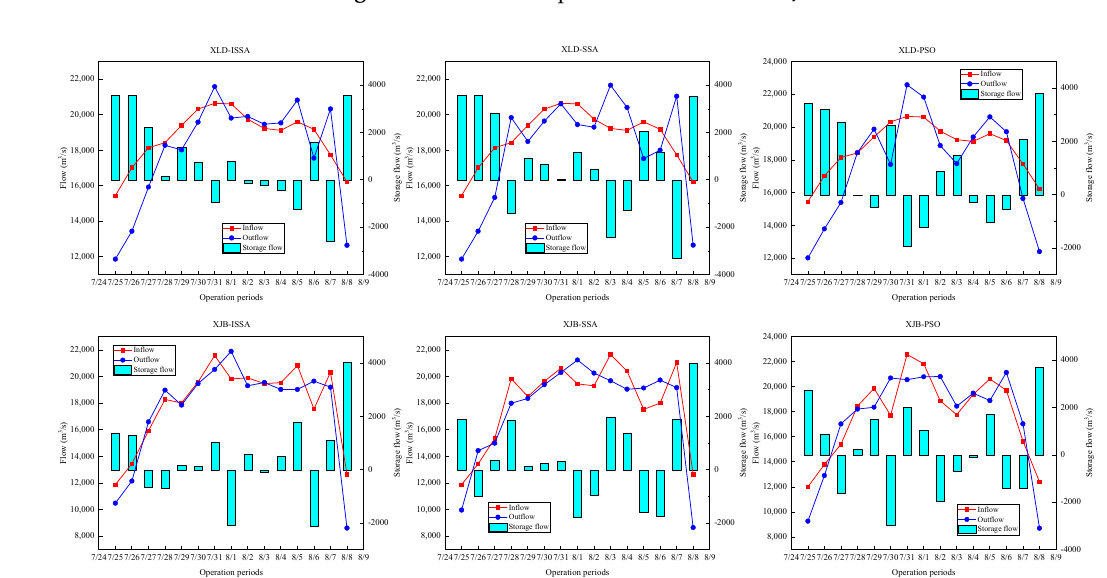
Figure 12. Flow processes of XLD and XJB. Table 7. Storage volume of XLD and XJB cascade